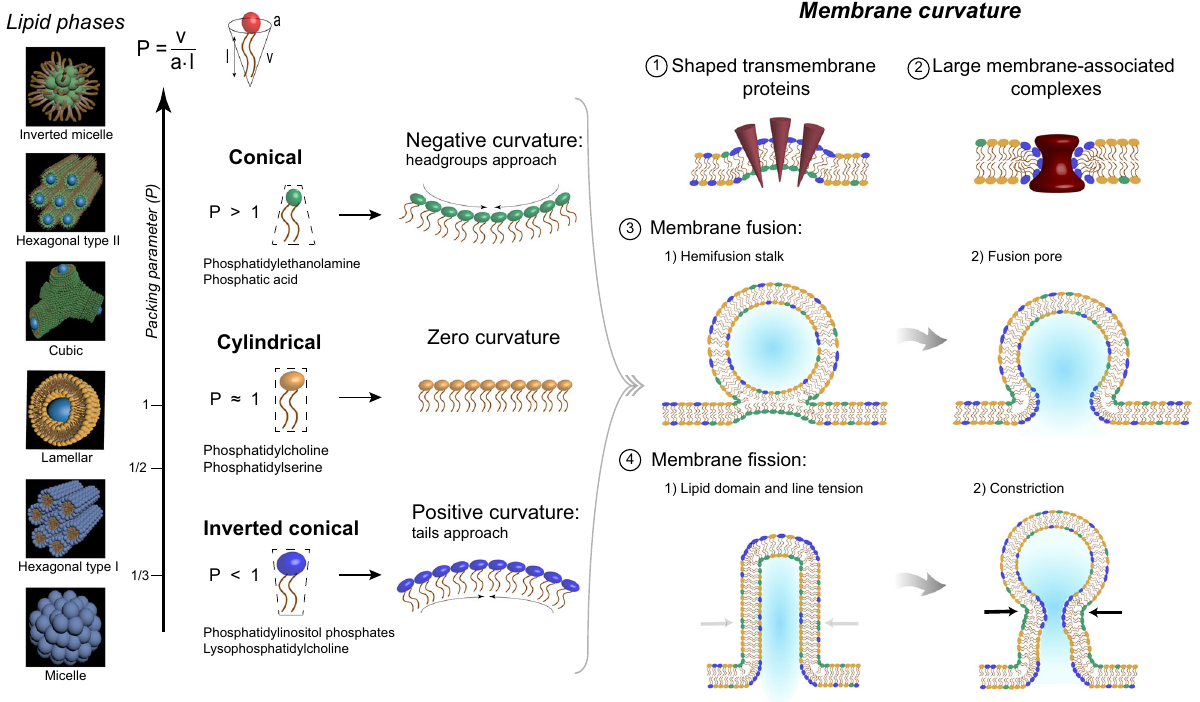
Fig. 4 Sketch of different lipid phases that can be detected by SAXS and their signi fi cance for cell membranes. Membrane curvature and relationship with lipid phases detected by SAXS. Left, different lipid phases detected by SAXS and ordered by their packing parameter ( P p = v / a × l , where v is the molecular volume, l is the molecular length, and a is the molecular area at the hydrocarbon-water interface). Molecules with high packing parameter (i.e., small head groups) have a conical geometry and tend to bend to negative curvatures (green), contrary to molecules with little P , which have an inverted conical geometry and bend to positive curvatures (blue). Right, clusters of conical or inverted conical lipids indicate the different curvatures of the membrane: negative (green) and positive curvatures (blue). 1 – 2: Different proteins anchor to membrane that require characteristic curvatures to be functional. 3: Process of membrane fusion, fi gures represent the two main steps where non-zero curvatures are needed. 4: Process of membrane fi ssion, this process also needs characteristic membrane